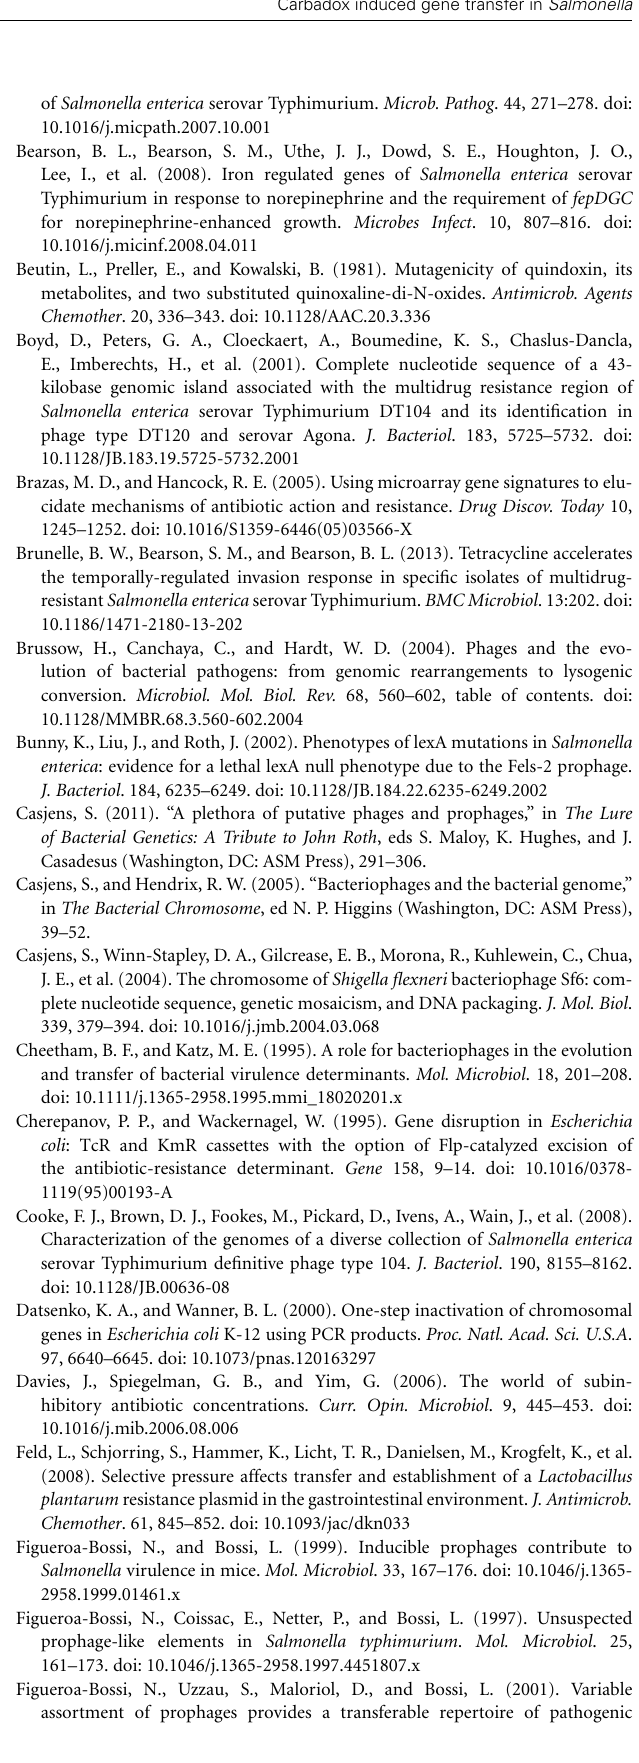
Figueroa-Bossi, N., Uzzau, S., Maloriol, D., and Bossi, L. (2001). Variable assortment of prophages provides a transferable repertoire of